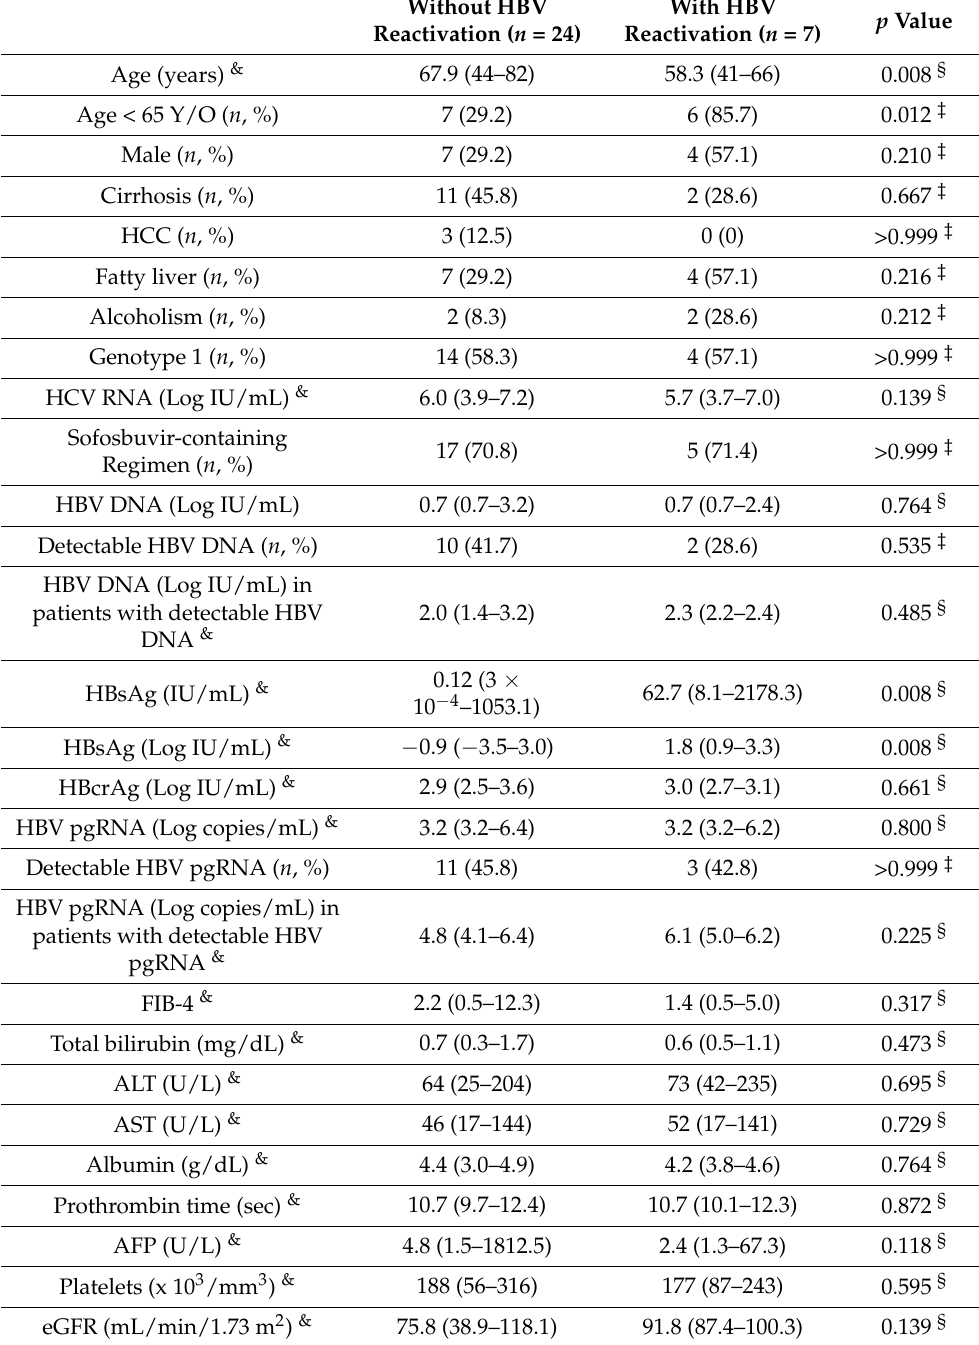
Table 2. Baseline clinical and virological characteristics of HBV with/without reactivation in HBV/HCV coinfected patients receiving DAA therapy without nucleot(s)ide analogue treatment ( n =